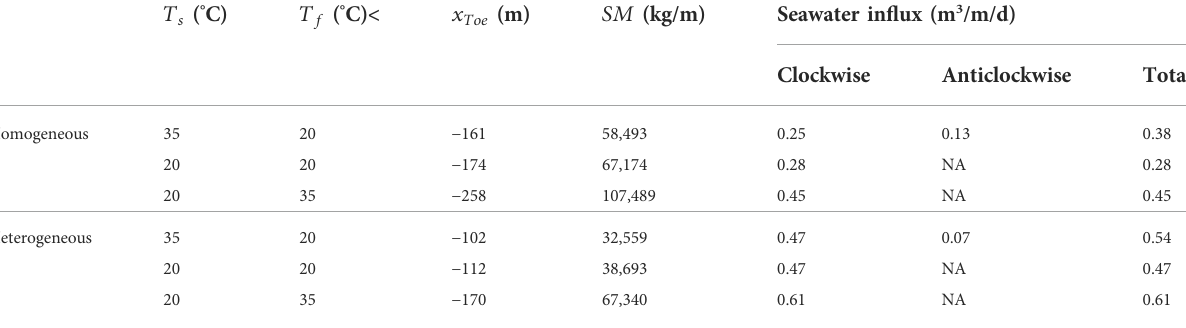
Clockwise Anticlockwise Total